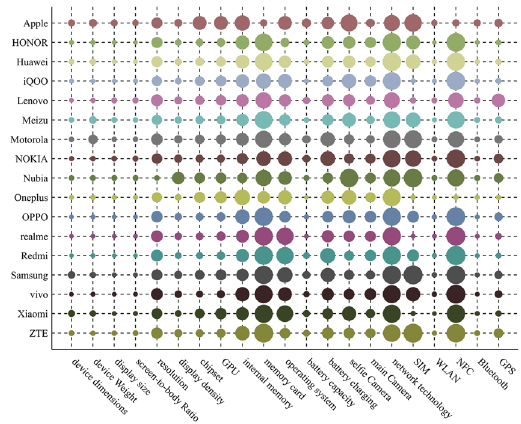
Figure 3. On each brand, the standard deviation of intra-brand similarity increments of different extracted feature. The size of circle presents absolute value of similarity increment. The bigger the circle is, the larger the value